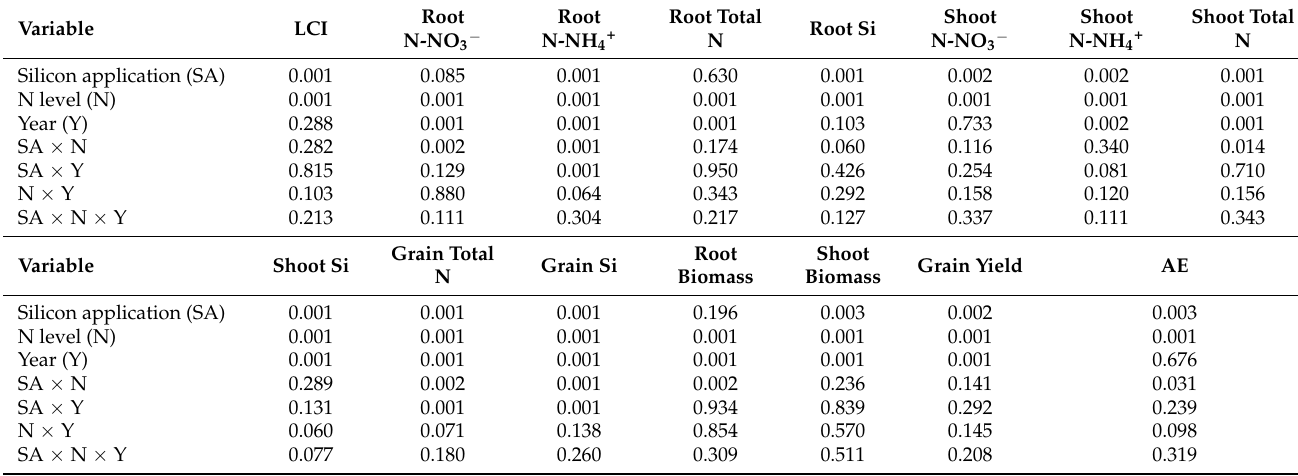
Table A1. Summary of statistical analysis ( p -values) for maize leaf chlorophyll index (LCI) root and shoot nitrate (N-NO 3 − ), ammonium (N-NH 4+ ), total N and Si accumulation, grain total N and Si accumulation, root and shoot biomass, grain yield and agronomic efficiency (AE) affected by Si application, N level, year and their interactions. Variable